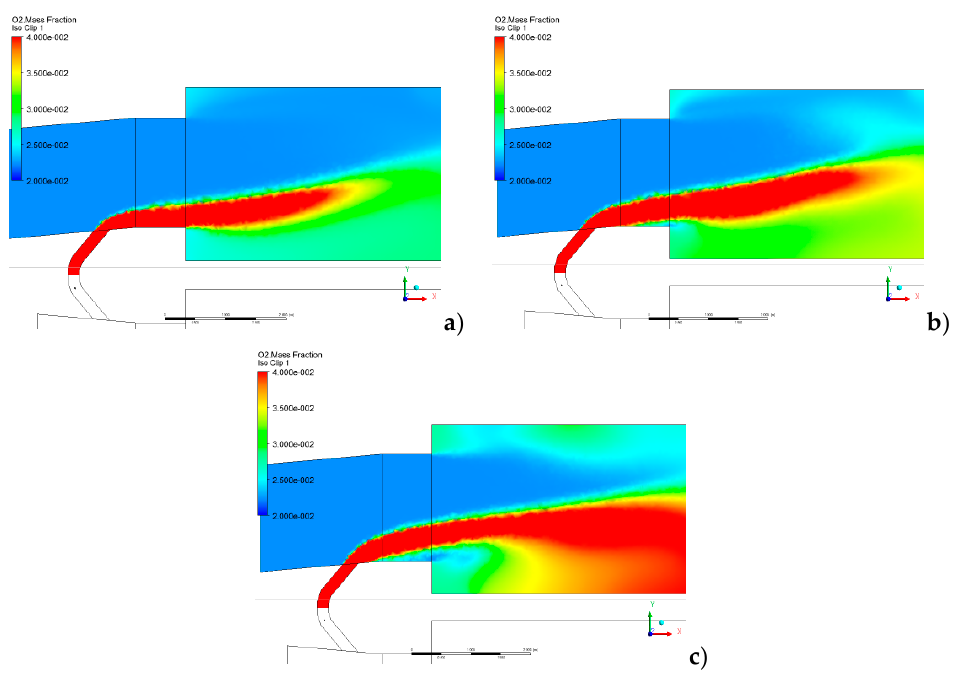
Figure 18. O 2 mass fraction at the top chamber cons massflow 30 m 3 /h—( a ) 50 m 3 /h ( b ) 60 m 3 /h ( c ) 80 m 3 /h.